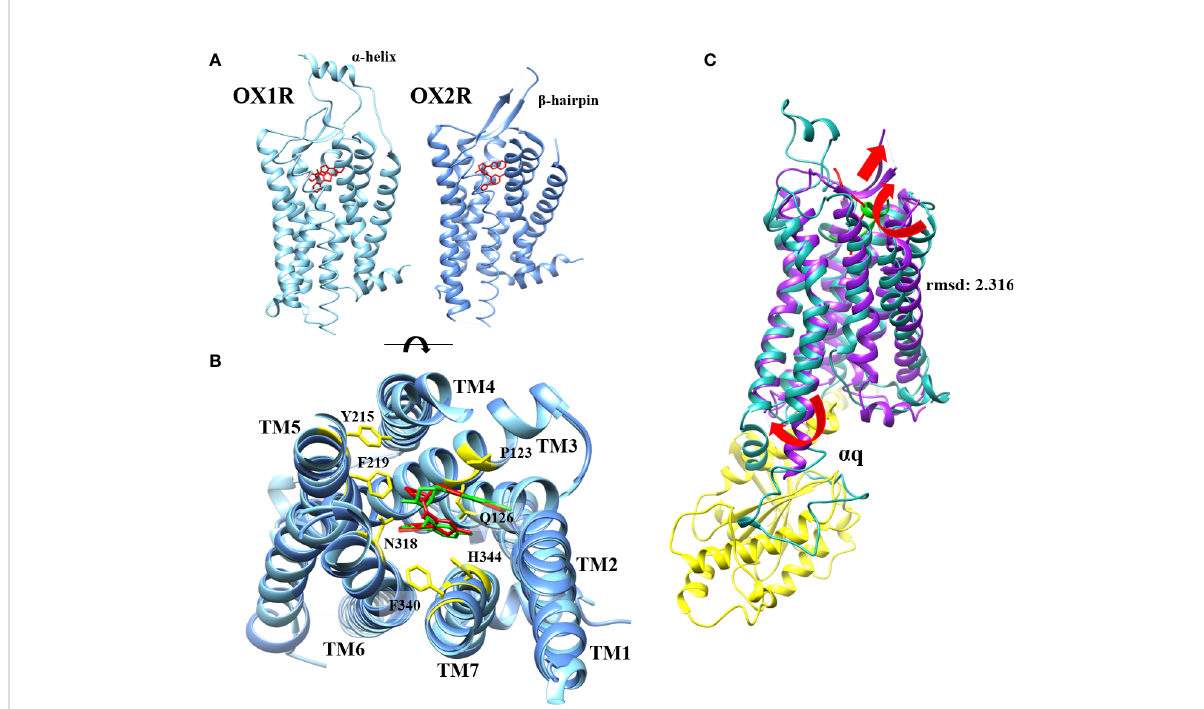
FIGURE 3 OX1R-suvorexant and OX2R-suvorexant structures (A) , orthosteric site of OX1R-suvorexant and OX2R-suvorexant (B) and comparison between OX2R-OxB structure obtained by cryo-EM and OX1R-OxB 3D model obtained by homology modeling associated to molecular dynamic simulation (C) . (A) (left): OX1R X-ray structure (light blue) bounded to suvorexant (red). (A) (right): OX2R X-ray structure (corn fl ower blue) bounded to suvorexant (red). Panel B: Orthosteric site of OX1R (light blue) bounded to suvorexant (red) and OX2R (corn fl ower blue) bounded to suvorexant (green). OX1R and OX2R residues involved in suvorexant interactions (yellow). Panel C: OX2R cryo-EM structure (purple) bounded to OxB (red) and OX1R 3D model (light sea green) bounded to C-terminal domain of OxB (green). a q subunit of mini-Gq protein (yellow). Red arrows indicate TM movements in active